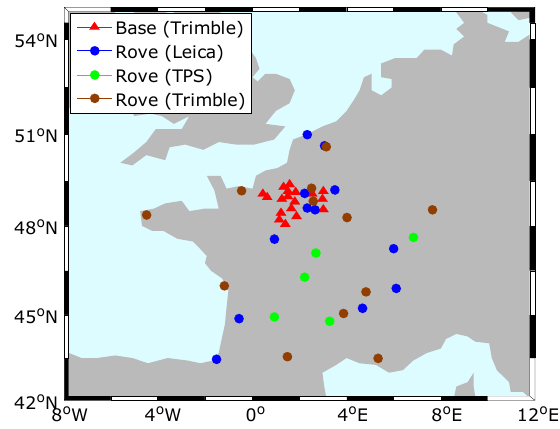
Figure 2. Distribution of 18 base stations and 29 rover stations used in France.